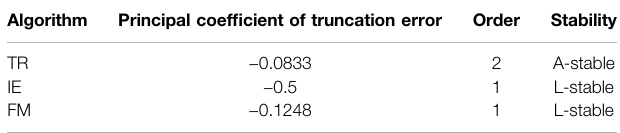
TABLE 1 | Comparison of three numerical